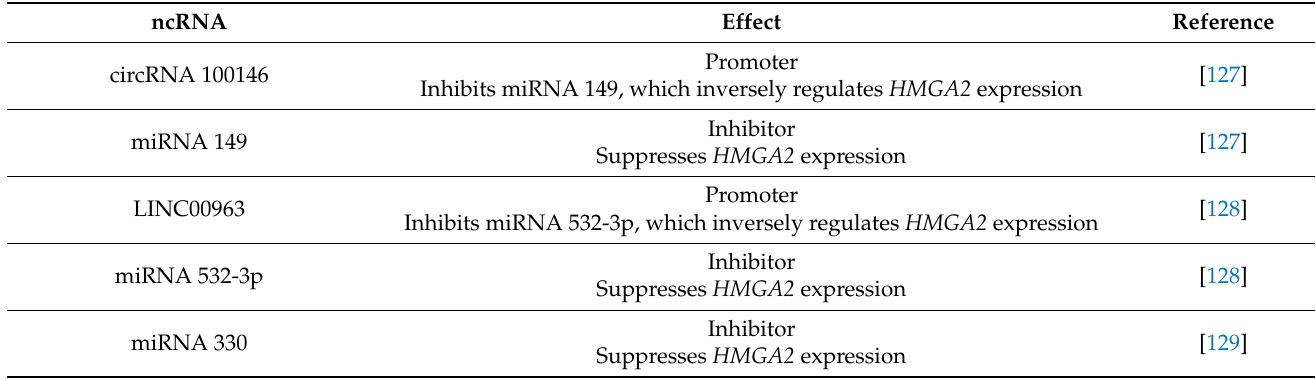
Figure 3. HMGA2 supports chemoresistance and genome maintenance in CRC. Schematic depicting the mechanisms by which HMGA2 counteracts treatment-induced DNA stress and protects genome integrity. RF, replication fork; ssDNA, single strand DNA; ATM, ataxia telangiectasia mutated; ROS, reactive oxygen species; PARP, Poly [ADP-ribose] polymerase 1; TOPO, topoisomerase. Table 2. Non-coding RNAs that regulate HMGA2 in